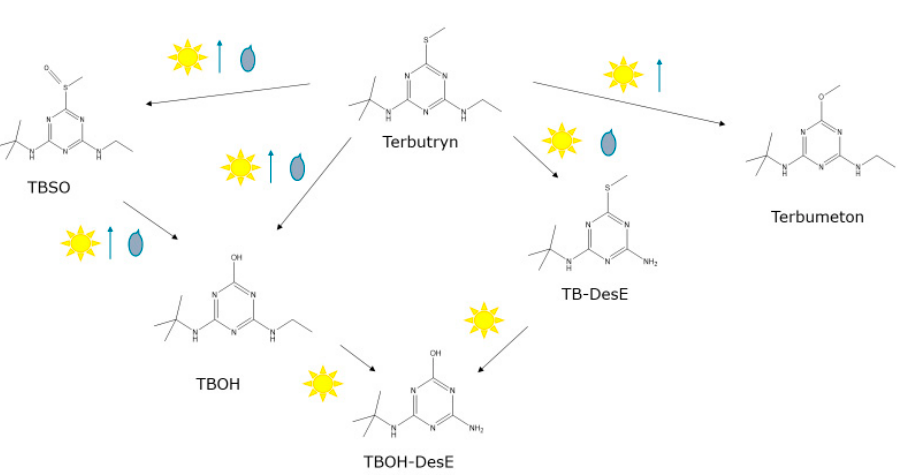
Figure 6. Transformation of terbutryn under different experimental conditions. The scheme is restricted to the transformation products that were observed during this study. It indicates whether reactions occurred due to water contact during immersion cycles (symbol: water drop), under UV radiation (symbol: sun), or if they increased if UV radiation was combined with immersion cycles (symbol: blue arrow).